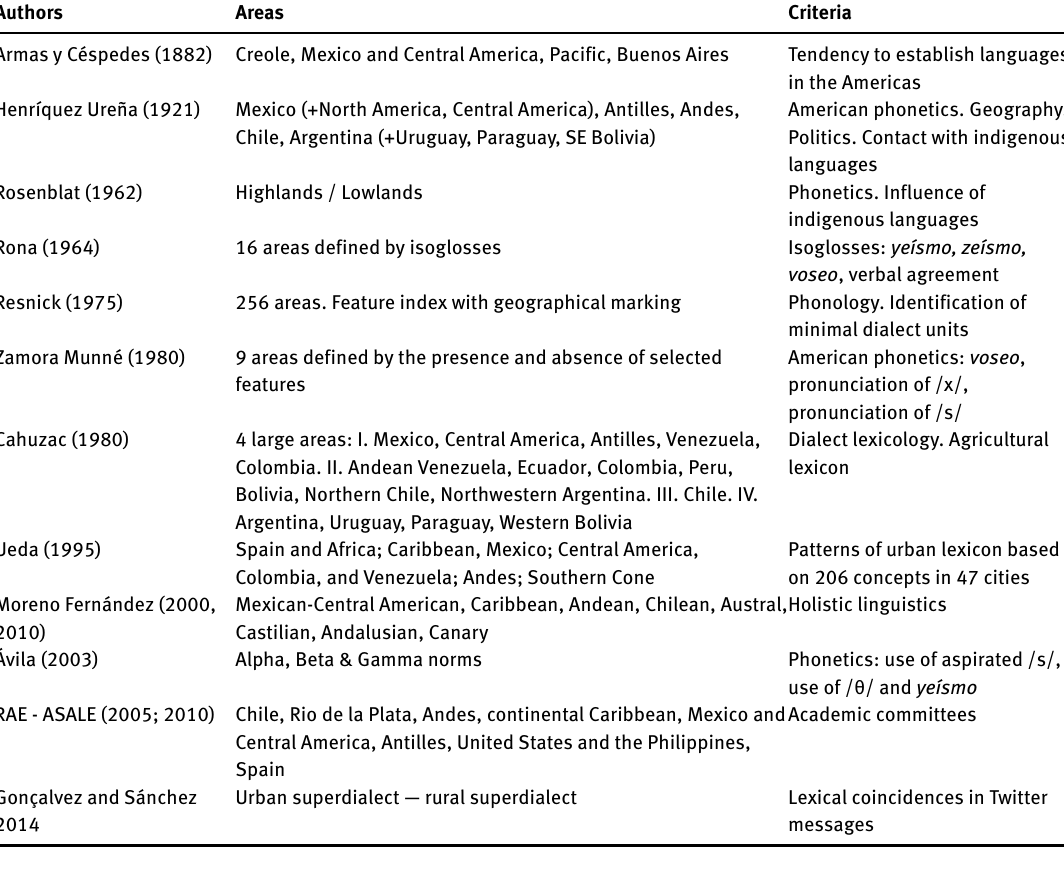
Table 1. Proposals for dialect zoning of the Spanish